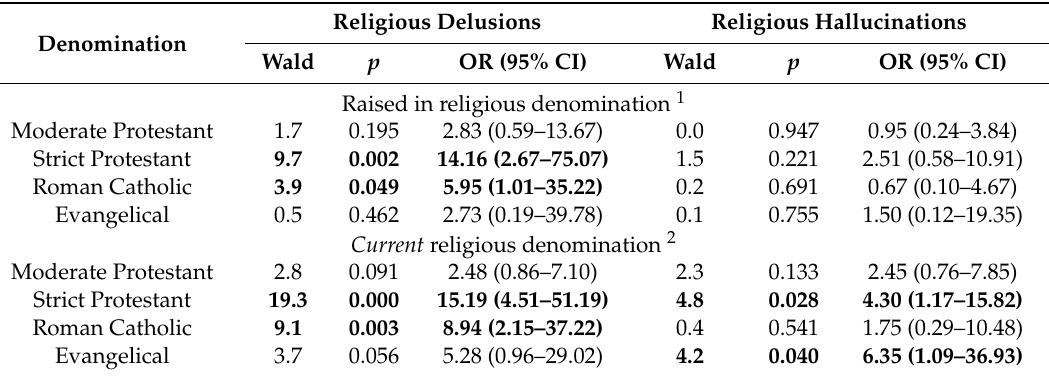
Table 4. Associations between religious denominations (raised and present) and RDs and RHs in a sample of 155 patients; results from separate logistic regression analyses for each aspect of religious denomination, adjusted for e ff ect by